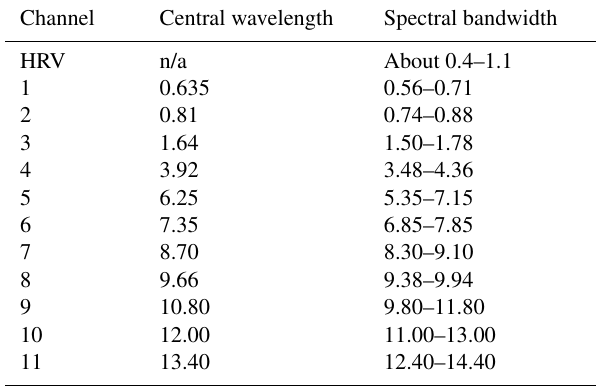
Table B1. MSG SEVIRI channels. Specifications include channel number, central wavelength (µm) and nominal spectral bandwidth